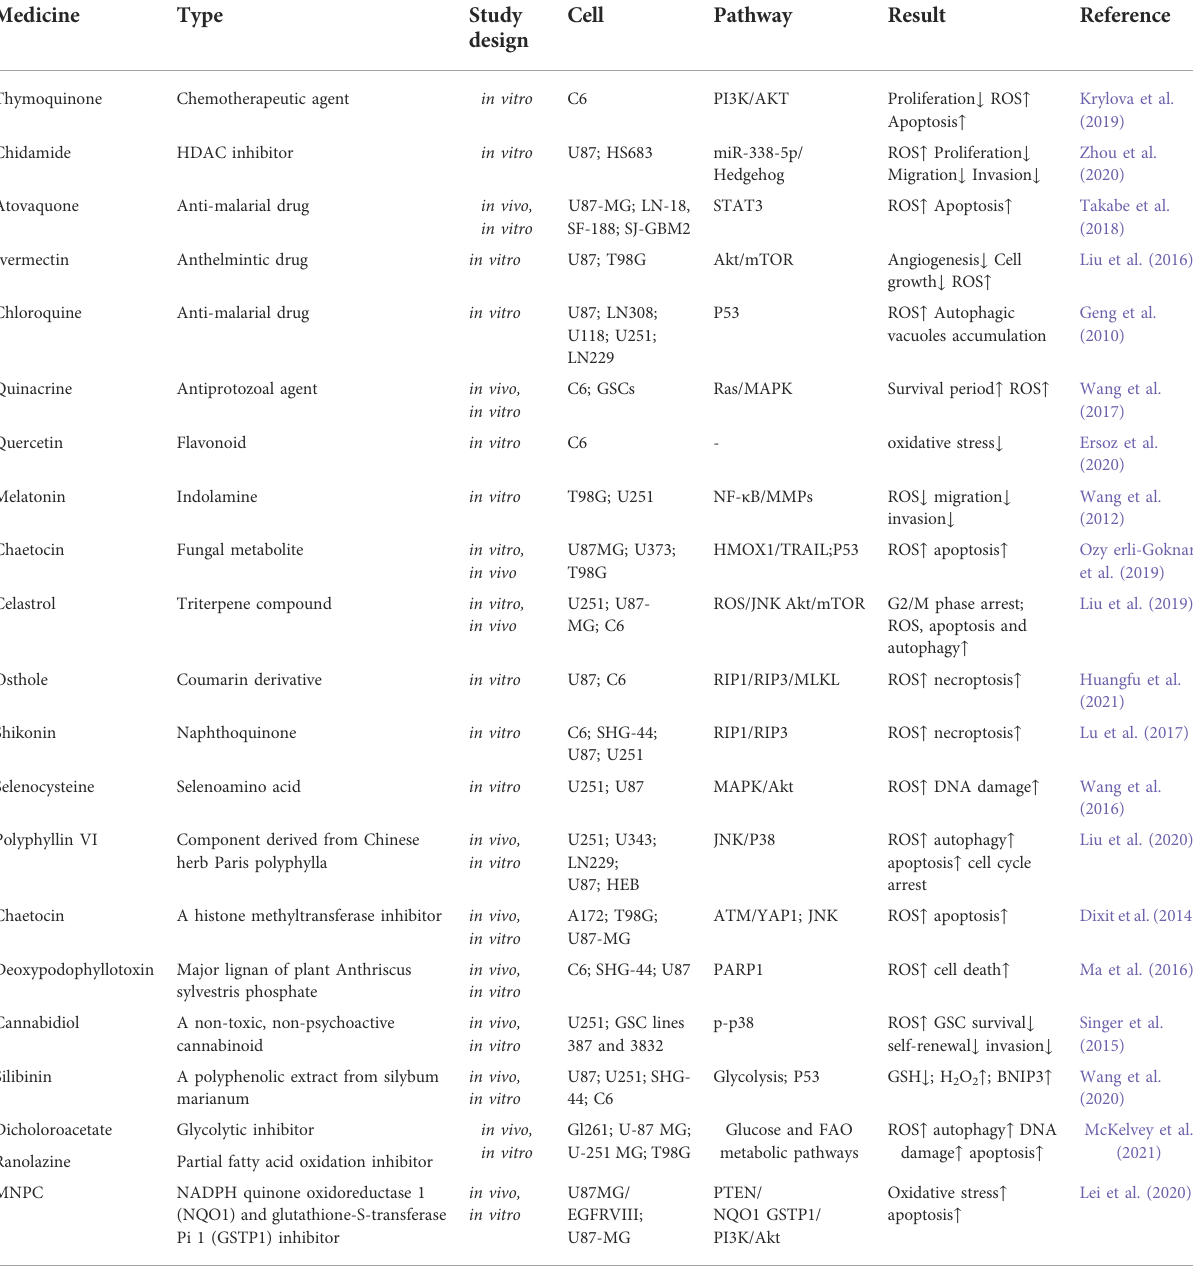
TABLE 2 Summary of studies on medicines linked to ROS in gliomas.